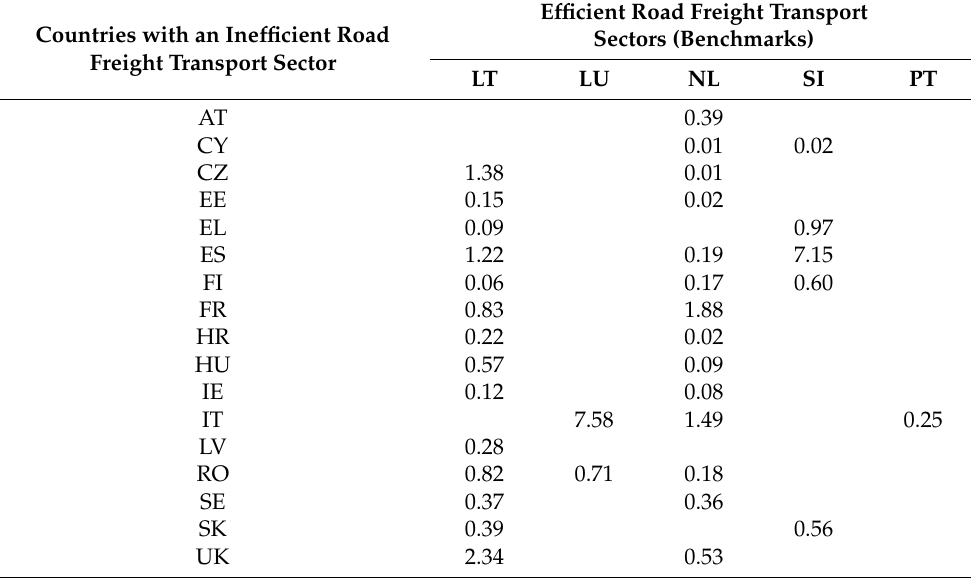
Table 4. The reference set (lambda) for inefficient road freight transport sectors.